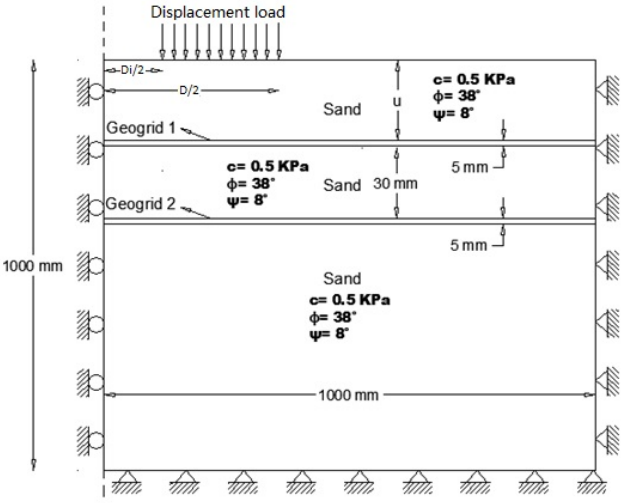
Figure 1. Illustration of the model domain, load, and boundary condition .